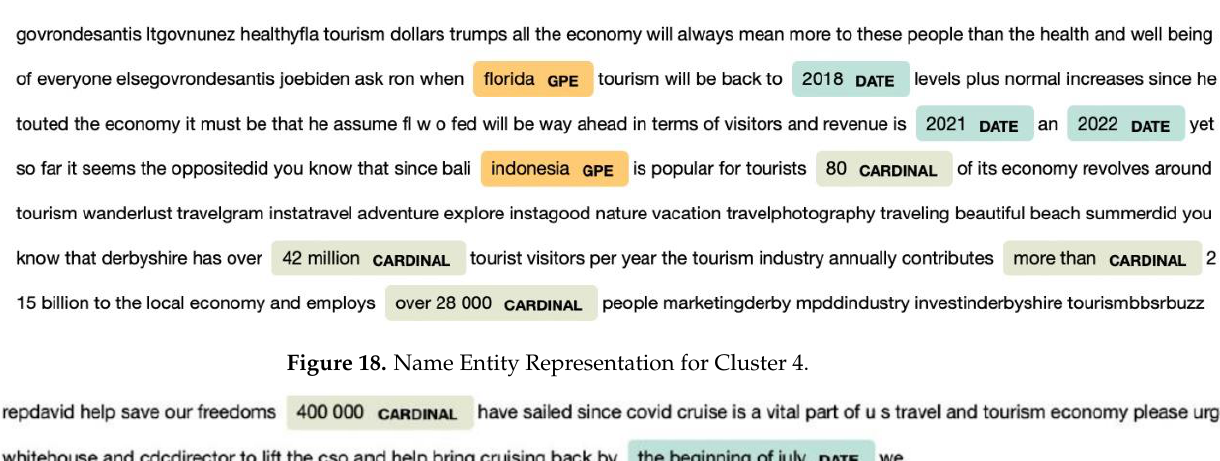
Figure 19. Name Entity Representation for Cluster 5.